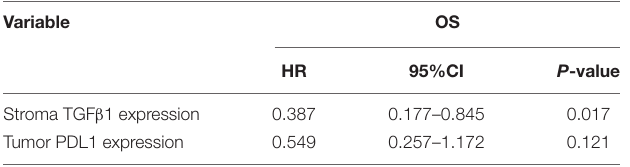
TABLE 4 | Multivariate LASSO-Cox regression analysis for OS in patients with